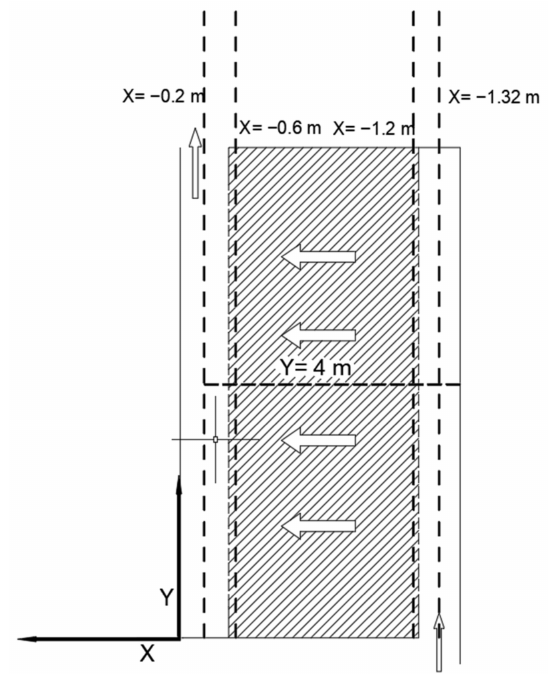
Figure 4. Schematic of the values for x and y, which cuts are taken.